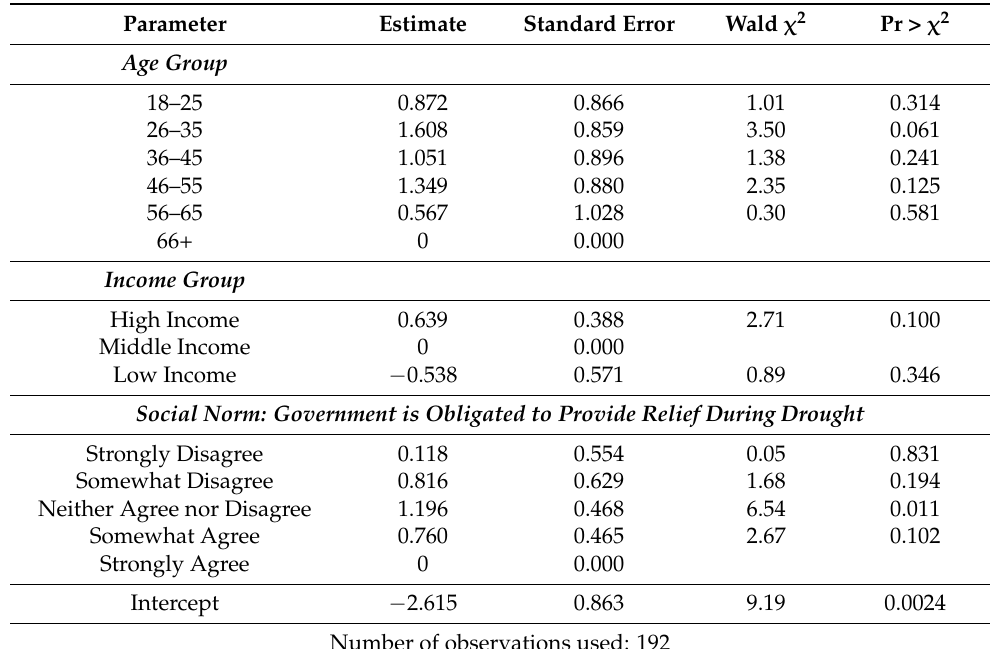
Table 8. Binomial logistic regression of DF toilet installation and age group, income group, and belief in government responsibility to provide